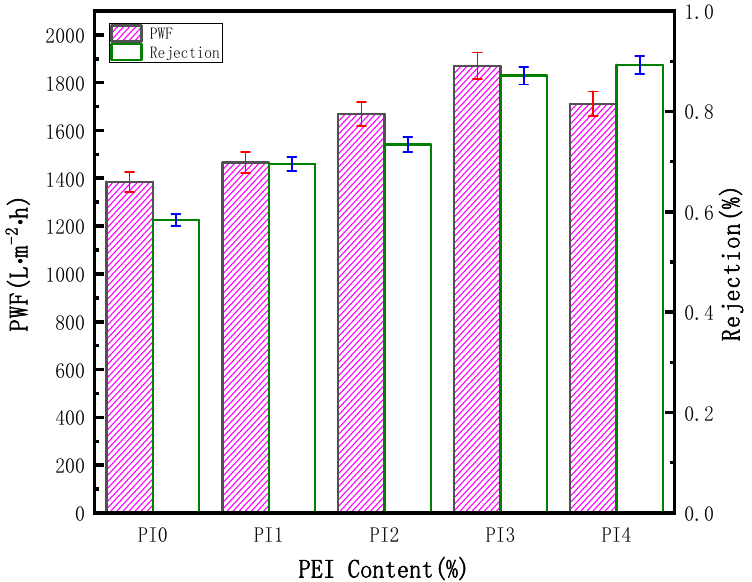
Figure 9. Pure water flux and oil rejection rates of various PVDF/PEI membranes.